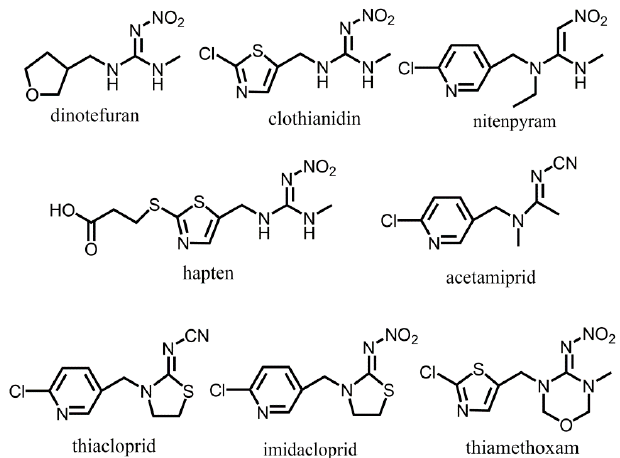
Figure 1. Molecular structures of analytes and hapten.